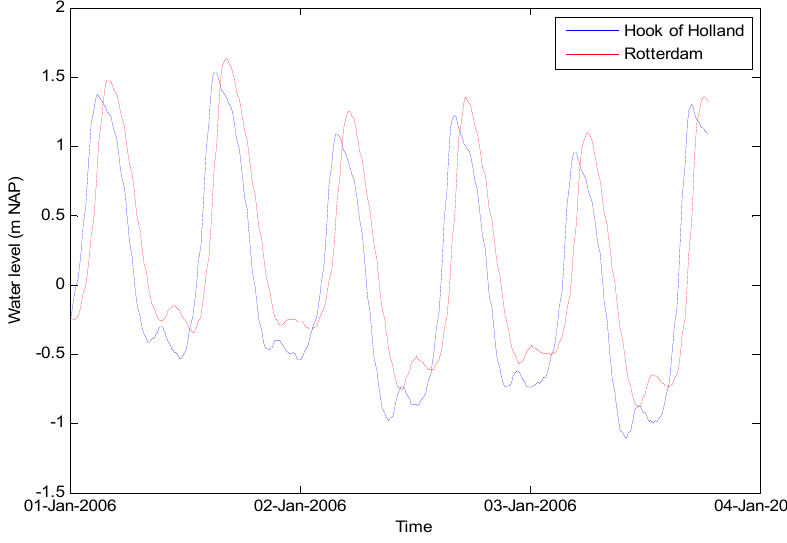
Figure 7. Observation of water level at Rotterdam and Hook of